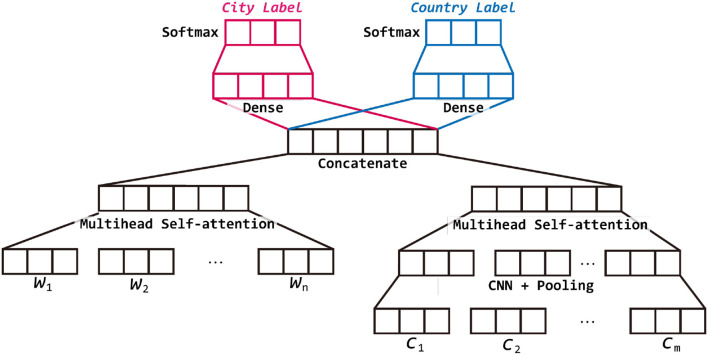
Overview of our proposed model.